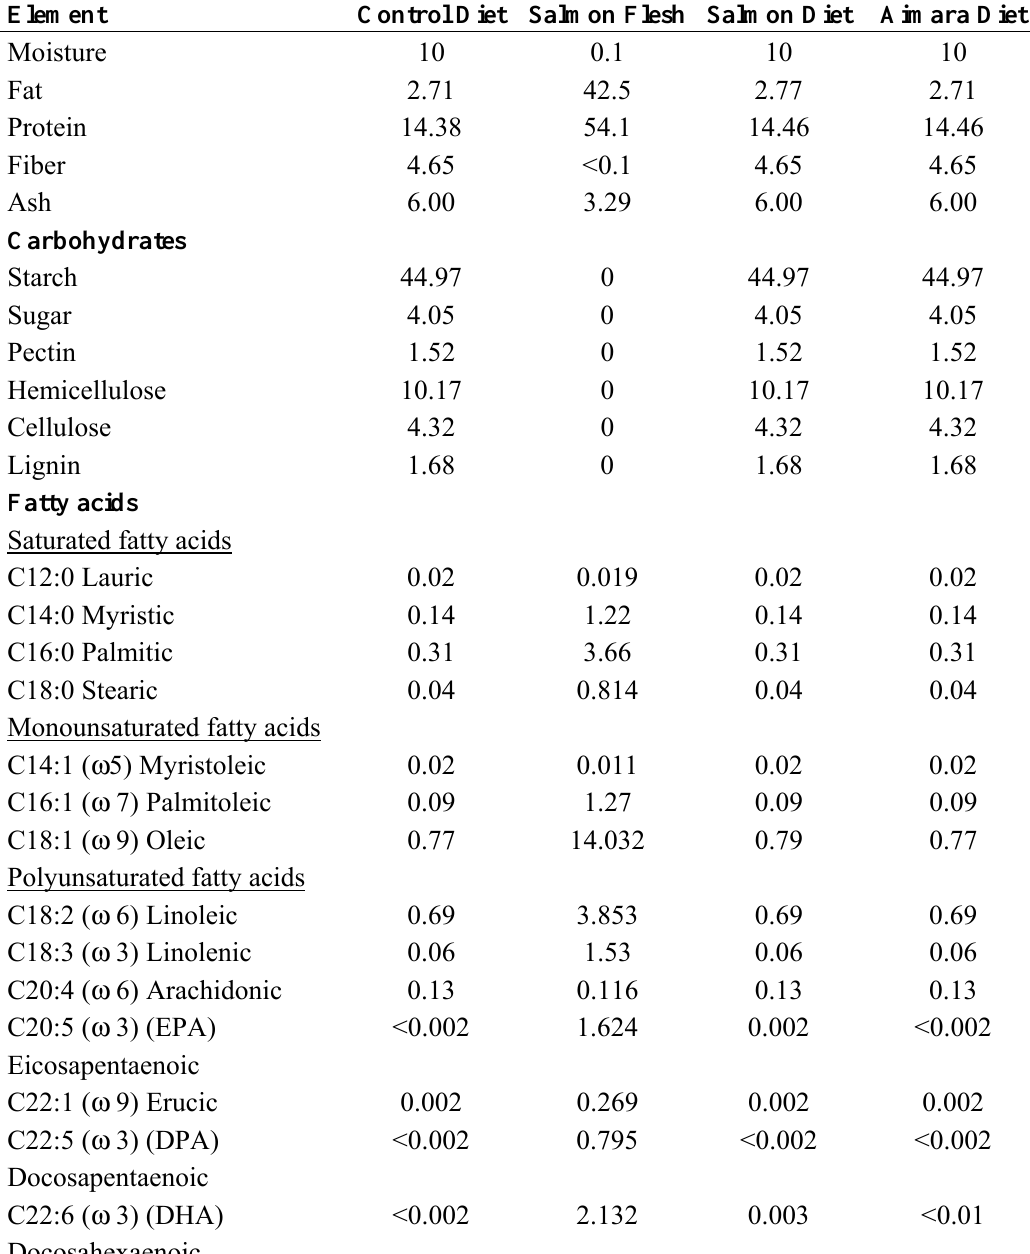
Table 1. The composition of the salmon flesh and diets used.